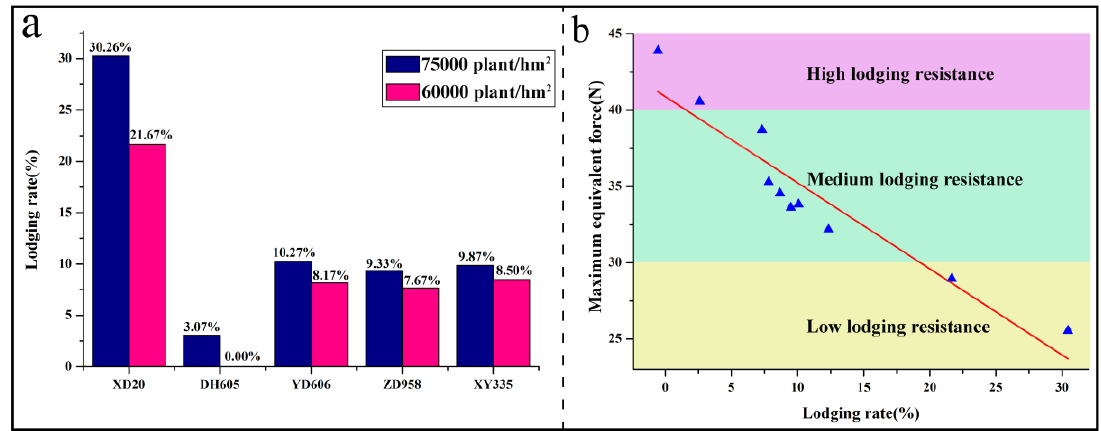
Figure 7. ( a ) The lodging rate calculated from the experiment samples; ( b ) the correlation between the maximum equivalent force and lodging rate.